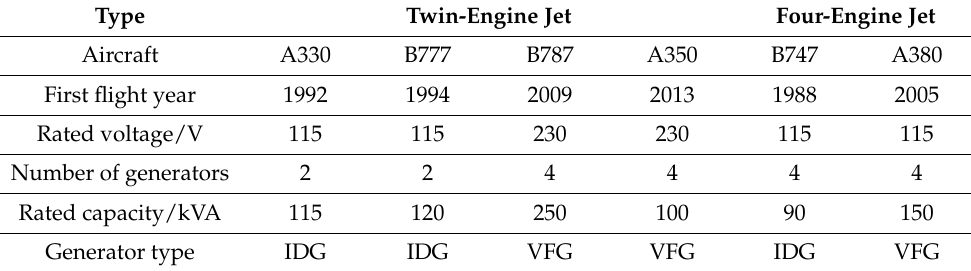
Table 1. Typical wide-body passenger aircraft power system capacity data [4].